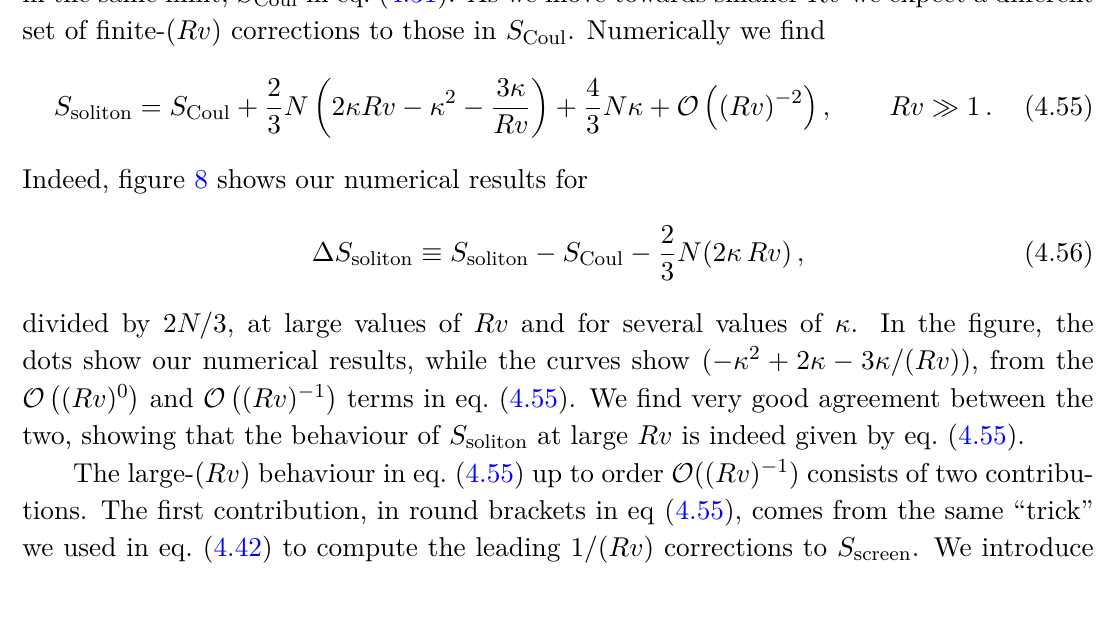
Figure 7 . Left: the black dots are our numerical results for S soliton /N in eq. (4.54) at the position of its maximum ( Rv ) max as a function of ( Rv ) max . The solid red line is a fit to a function ∝ ( Rv ) 1 . 2 Right: the black dots are our numerical results for S soliton /N at R = R 0 , with R 0 = κ/v the spherical soliton’s radius (and we set v = 1 ), as a function of κ . The solid red line is a fit to a function ∝ κ 1 . 3